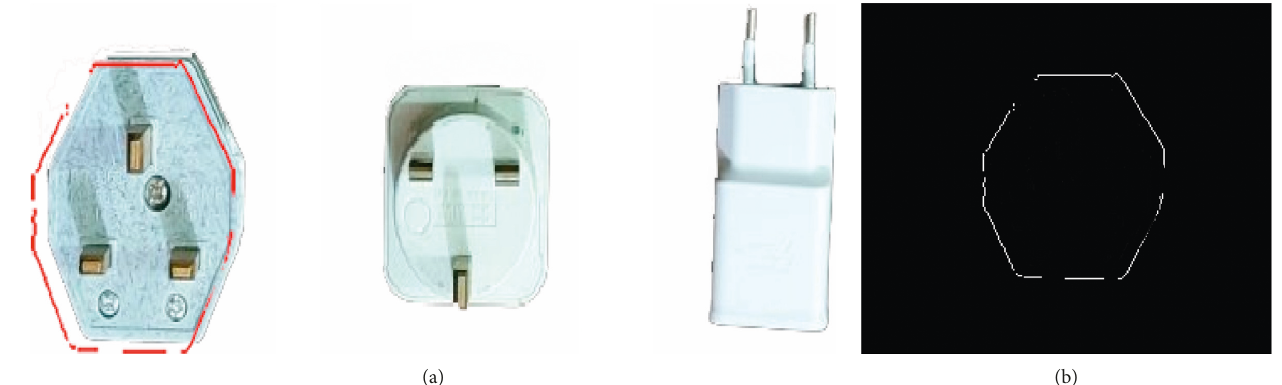
Figure 10: The matching of Prewitt edge method: (a) product image captured; (b) template